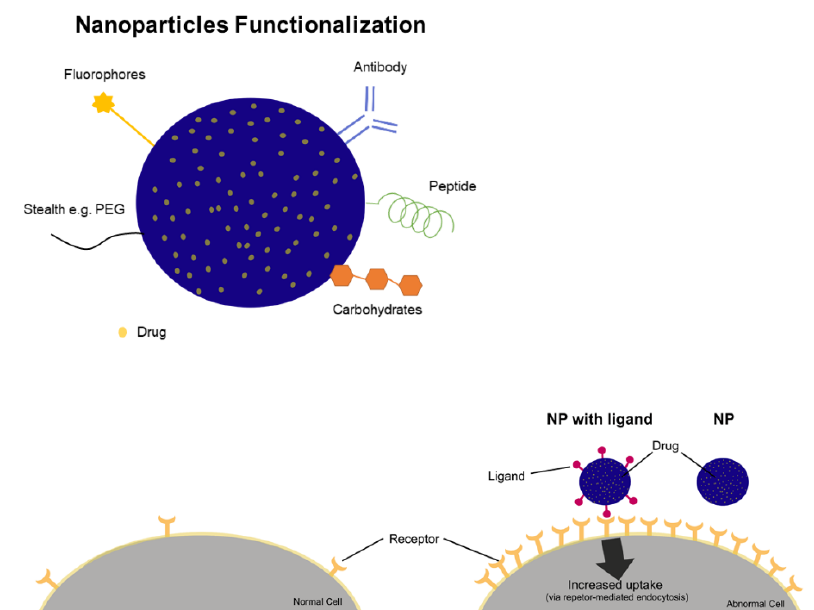
Figure 4. Representation of examples of functionalization to NPs with PEG for stealth NP, with fluorophores for imaging. Functionalization with ligands (e.g., antibody, peptide, carbohydrate and others) can show an advantage in abnormal cells with receptor’s overexpression to enhance uptake by the cells mediated by a receptor endocytosis.